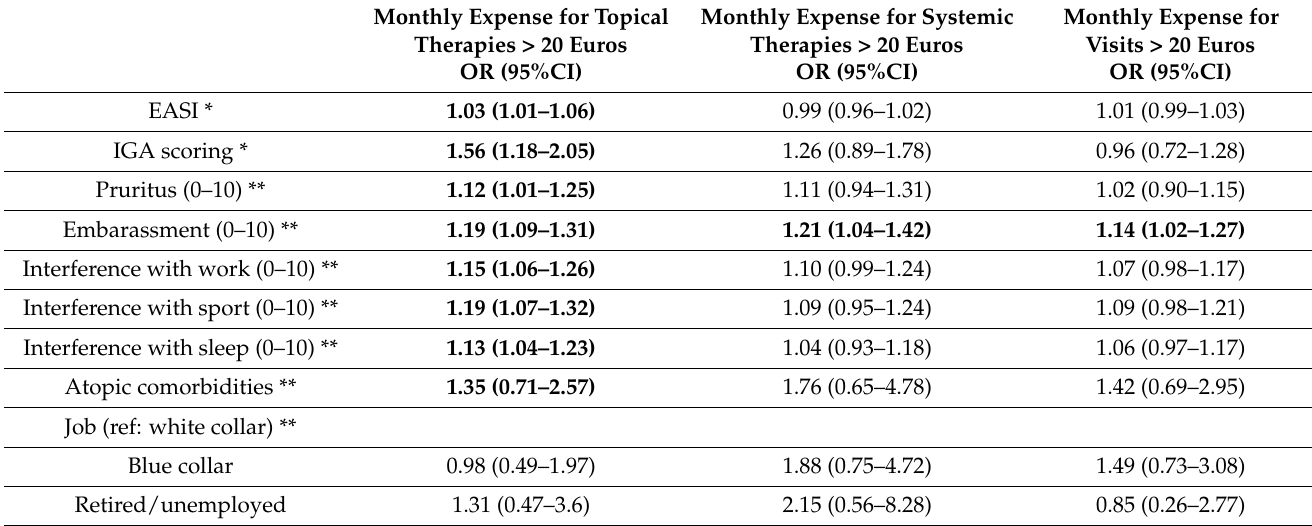
Legend. * Model adjusted for: age, gender ** Model adjusted for age, gender, EASI. Statistically significant results are highlighted in